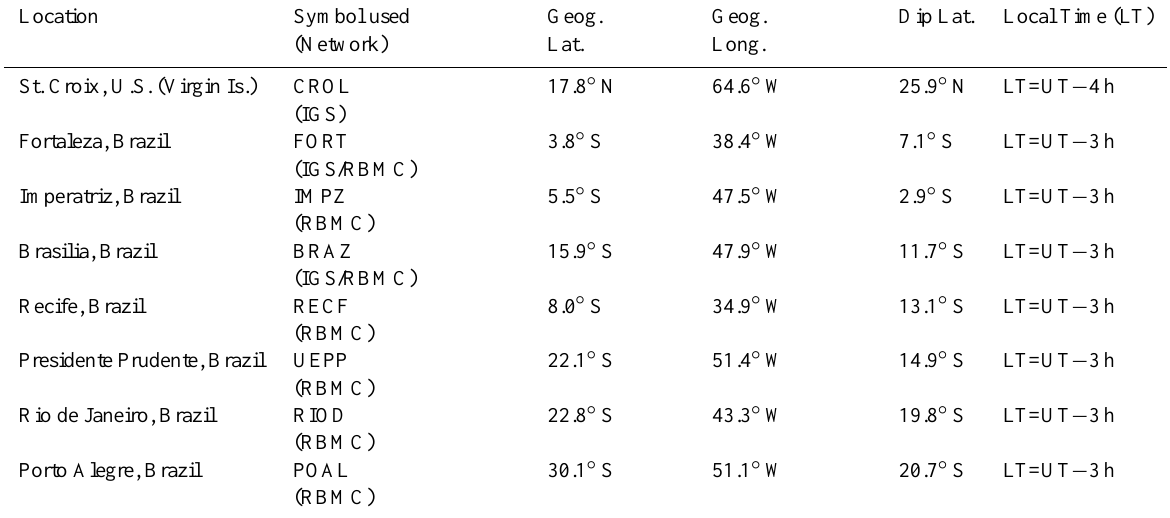
Geog. Geog. Dip Lat. Local Time (LT) Lat. Long.